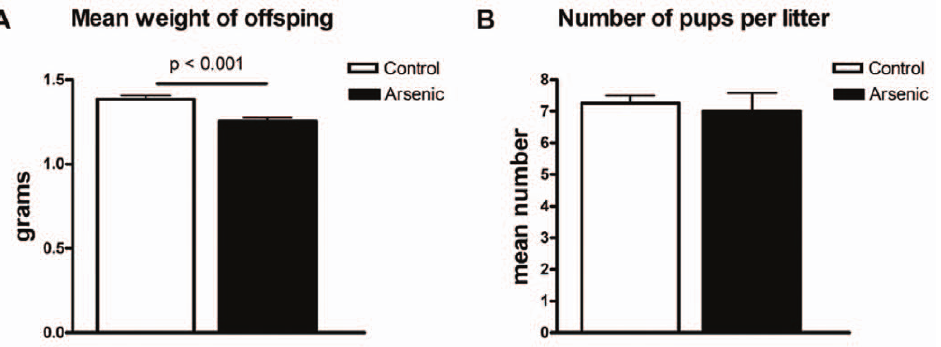
Figure 1. Pups’ weight but not litter size is decreased by prenatal exposure to arsenic. A . The mean weight of the pups is decreased approximately by 10% in arsenic treated mothers. P , 0.05 by t-test. B . Number of pups per pregnant dam is not significantly changed by arsenic treatment.